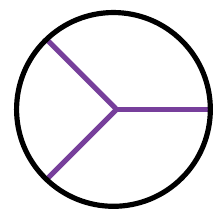
Figure 6. Witten diagram contributing to (cid:12) 1 at leading order in 1 =N